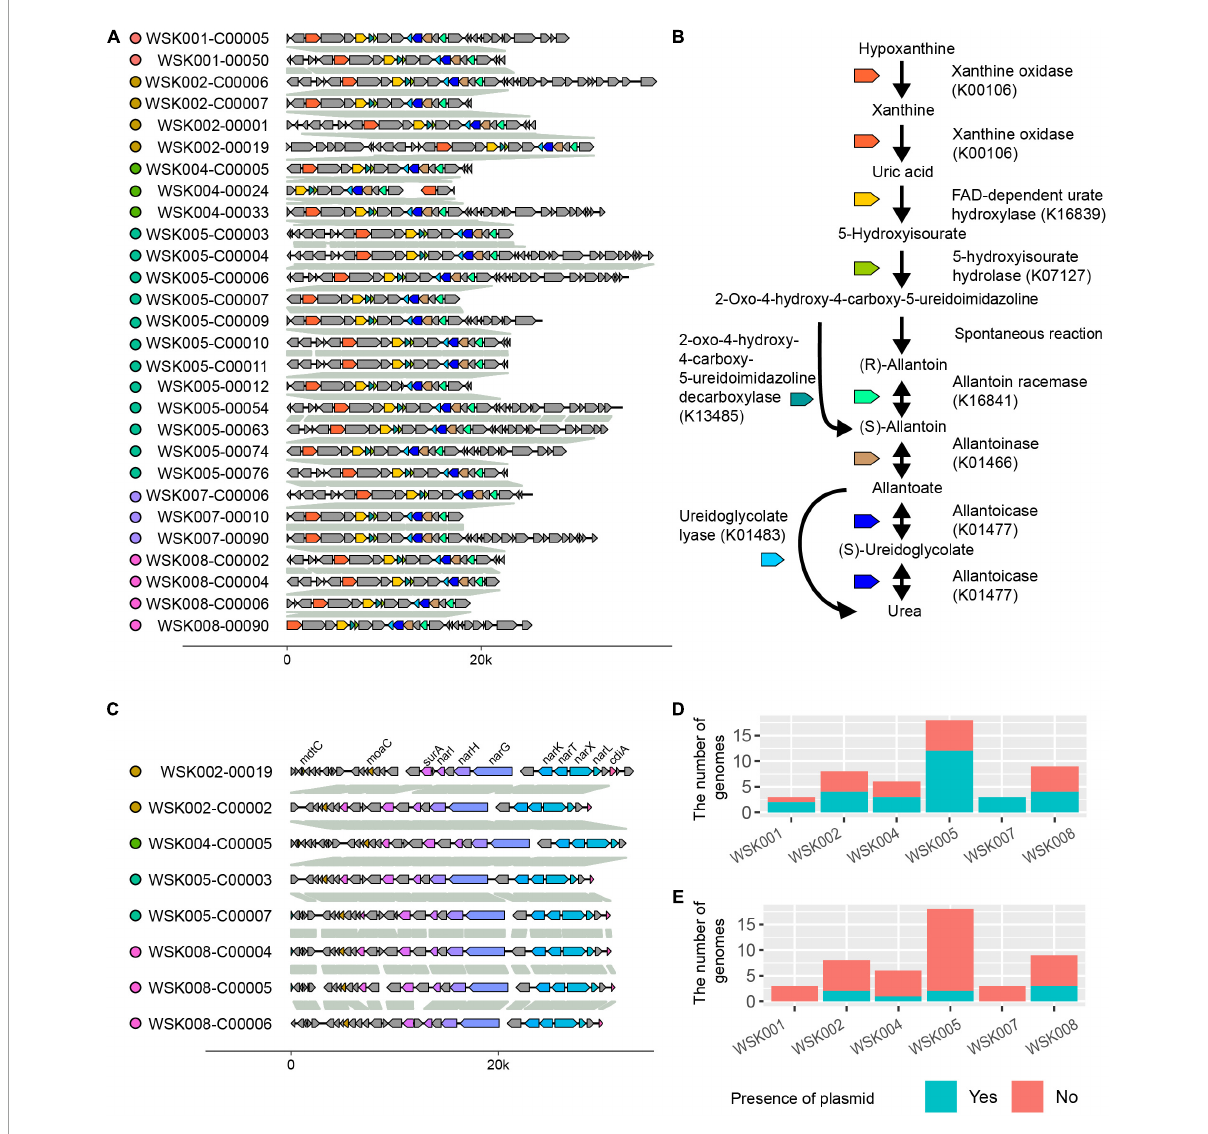
FIGURE5 Plasmids found in Moraxella osloensis high-quality single-amplified genomes (HQ SAGs). (A) Synteny analysis of contigs predicted as plasmid sequence shown in Figures 4A-A . (B) Predicted purine metabolic pathway found in the plasmid (A) . The pathway degrades xanthine to allantoin as an intermediate metabolite and urea as an end product. (C) Synteny analysis of contigs predicted as plasmid sequence shown in Figures 4A-B . The complete nitrate reductase operon conserving nar-related genes is observed. (D,E) The numbers of CoSAGs harbor the genes shown in panels (A,C) in the